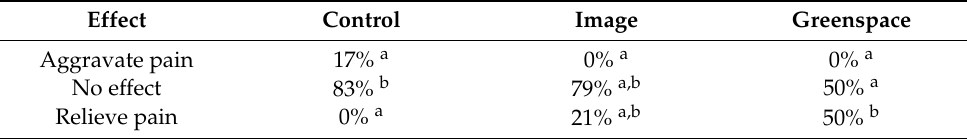
Table 4. Differences in proportions of participant with subjective responses.